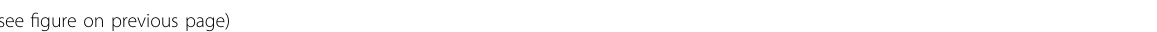
Fig. 6 Tracing relapsed leukemia cells and leukemia progression model. a Clustering of leukemia cell subpopulations of ALL3. b Healthy counterparts of leukemia cell subpopulations, the healthy cell populations are listed by order of lymphoid lineage. c , d Distributions of leukemia cell- speci fi c high variants on SRM ( c ) and DENND5A ( d ). e , f Distribution of relapsed leukemia cell-speci fi c high variants on IKZF1 ( e ) and RB1 ( f ). g Distribution of genetic variants in different cell subpopulations. h Hierarchical tree of leukemia cell subpopulations, in which relapsed leukemia cells and earlier leukemia cells in C5 were clustering together. i Distribution of reference haplotype and alterative haplotype of SSBP2 in BMMCs. j Frequencies of relapsed-speci fi c SSBP2 haplotype (alt haplo) in different leukemia cell subpopulations. k Progression model of patient ALL3. Ribbons with different colors present different leukemia subpopulations across the four stages, in which red ribbon stands for major leukemia cells (C1, C2) of diagnosis and refractory stages, blue and purple ribbons stand for relapsed leukemia cells (C5, C6), green is the minor population of leukemia cells from refractory to relapse stage, while light blue is normal